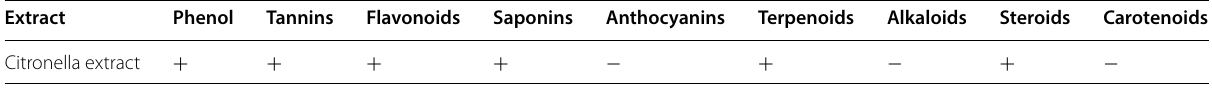
Table 1 Phytochemical analysis of citronella extract Extract Phenol Citronella